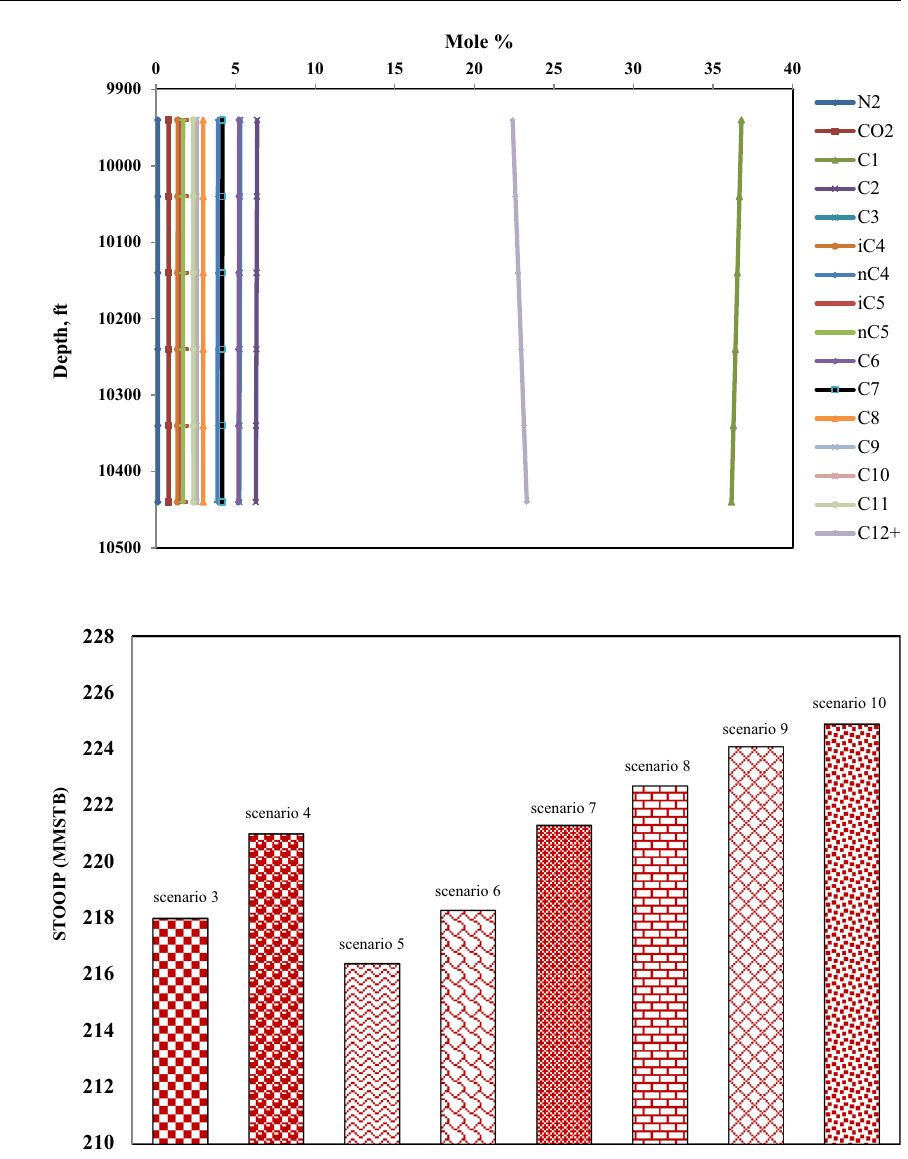
Fig. 4 Variations in molar percentages of reservoir fluid components with depth